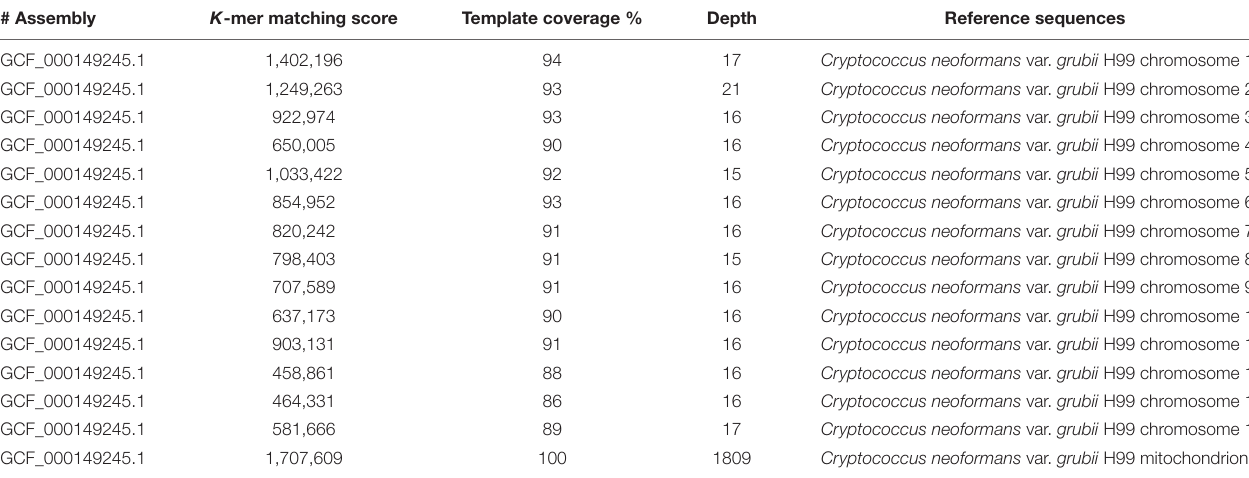
TABLE 1 | Results of identification of Cryptococcus isolate number C2 using KmerFinder bioinformatic